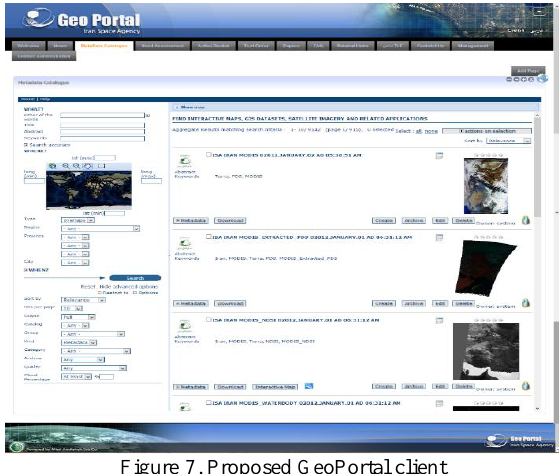
Figure 7. Proposed GeoPortal client